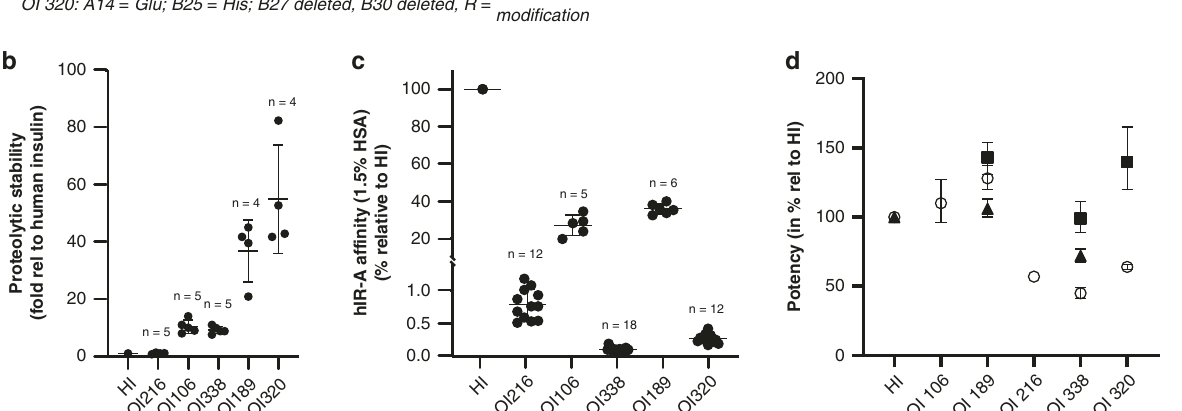
Fig. 2 Structure and main biological properties of insulin analogues. a Structures of the insulin analogues; note that R in HI, OI106, OI189 is hydrogen (i.e., chemically unmodi fi ed insulin) and that R in OI216, OI338 and OI320 is the chemical modi fi cation of B29 (see full drawing of chemical modi fi cation); Note that R is identical for OI216, OI338 and OI320 as illustrated in 2a) (all analogues are desB30). Insulin residues that are modi fi ed are A14 (Native Tyr, modi fi ed Glu), B25 (Native Phe), modi fi ed His), B27 Thr, modi fi ed by deletion (des), B30 Thr), modi fi ed by deletion (des). b Stability of the insulin analogues towards proteolytic degradation in rat duodenum extract. The degradation half-life relative to human insulin is shown (mean + / − SD from a number of independent experiments as indicated. c Receptor binding af fi nities of the insulin analogues relative to human insulin (HI = 100%) in the presence of 1.5% human serum albumin (HSA). Data are presented as mean values + / − SD from a number of independent experiments as indicated. d Potency of oral insulin analogues relative to human insulin on whole-body glucose disposal during different constant molar intravenous (IV) infusion rates to steady state (see the “ Methods ” section) under euglycemic clamp in healthy and conscious rats (circles), dogs (triangles) and pigs (squares), (con fi dence intervals is indicated and summaried in Table